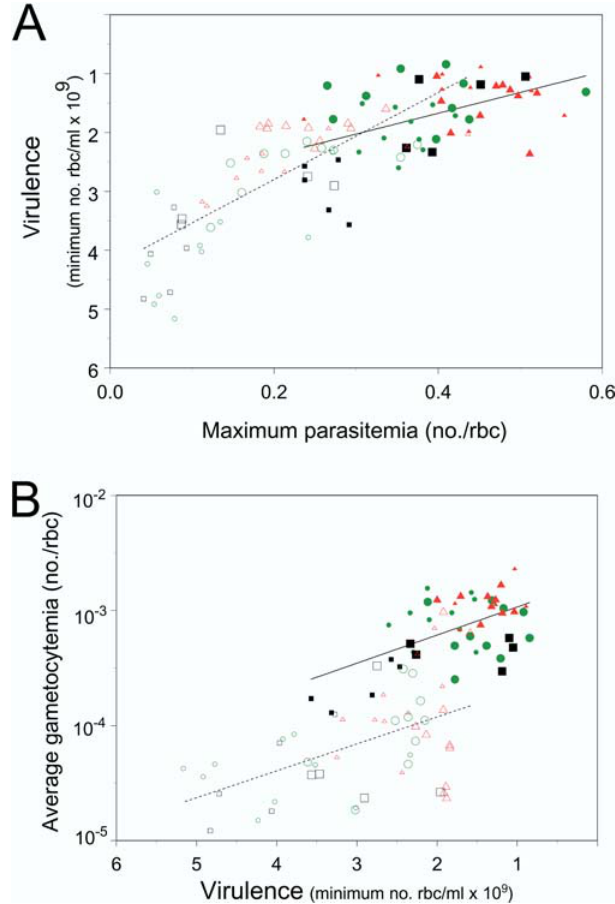
Figure 3. Relationships between Virulence, Asexual Multiplication, and Transmission Potential across Ancestral and Selection Lines Virulence, as measured by minimum red blood cell density, is plotted against maximum parasitemia in (A), and average daily gametocyte production (a measure of lifetime transmission potential) is plotted against virulence in (B). Data are all from pretransmission lines— ancestral and selected—measured in naı¨ve (closed symbols; solid line) and immunized mice (open symbols; broken line). Regression analysis for both traits showed significant ( p , 0.001) and similar ( p . 0.05) slopes within both naı¨ve and immunized mice, and significantly lower ( p , 0.001) maximum parasitemia and gametocyte production in immunized than in naı¨ve mice. When the two data points from naı¨ve mice with values of above 3 3 10 9 rbc/ml were excluded from the analyses, the slopes remained statistically similar ( p . 0.05). Unselected ancestral populations, black squares; N-lines, green circles; I-lines, red triangles; avirulent unadapted ancestral popula- tion, small symbols; virulent preadapted ancestral population, large